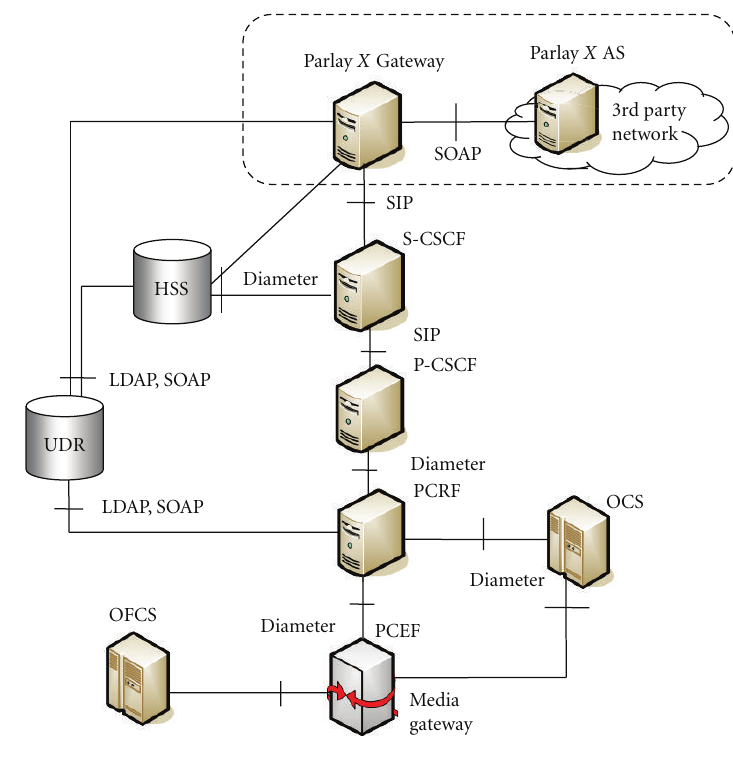
Figure 1: Deployment of Parlay X Web Services in